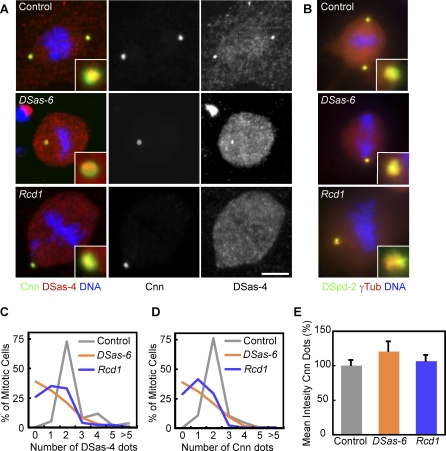
Genes Involved in Centriole Duplication (Class I)(A) S2R+ cells treated with dsRNA against GFP (control), DSas-6, and Rcd1 (CG8233) were stained with Hoechst (DNA, blue), DSas-4 (a centriole marker, red), and Cnn (a PCM marker, green). Inset shows a 4× magnified view.(B) Recruitment of DSpd-2 (green) and γ-tubulin (red) after dsRNA treatment for Control, DSas-6, and Rcd1. DNA is shown in blue, and inset shows a 4× magnified view.(C and D) Analysis of centriole (C) and centrosome (D) numbers in mitotic cells after RNAi treatment. More than 30 mitotic cells were counted in two independent experiments.(E) Analysis of PCM size in mitotic cells after RNAi treatment. The graph represents the mean intensity of PCM staining (Cnn) from three independent experiments, each analysing more than 20 centrosomes. Error bars represent the SE. Note how the number of centrioles and centrosomes per cell is reduced (C and D), whereas the amount of PCM recruited to the remaining centrioles is not affected (E) after DSas-6 and Rcd1 depletion.Scale bar in (A and B) represents 5 μm.